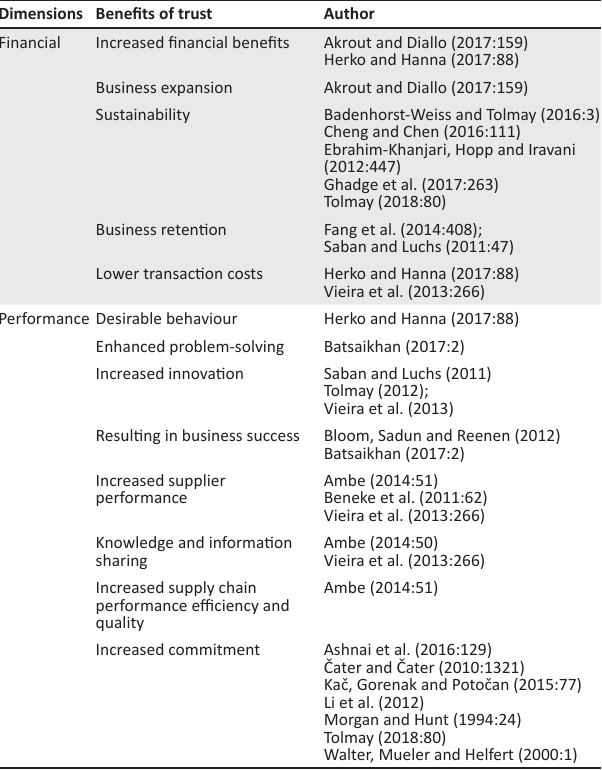
TABLE 1: Benefits of